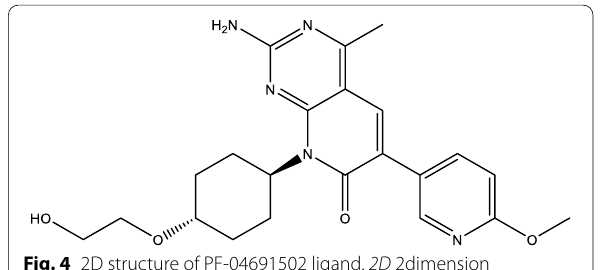
Fig. 4 2D structure of PF-04691502 ligand. 2D 2dimension